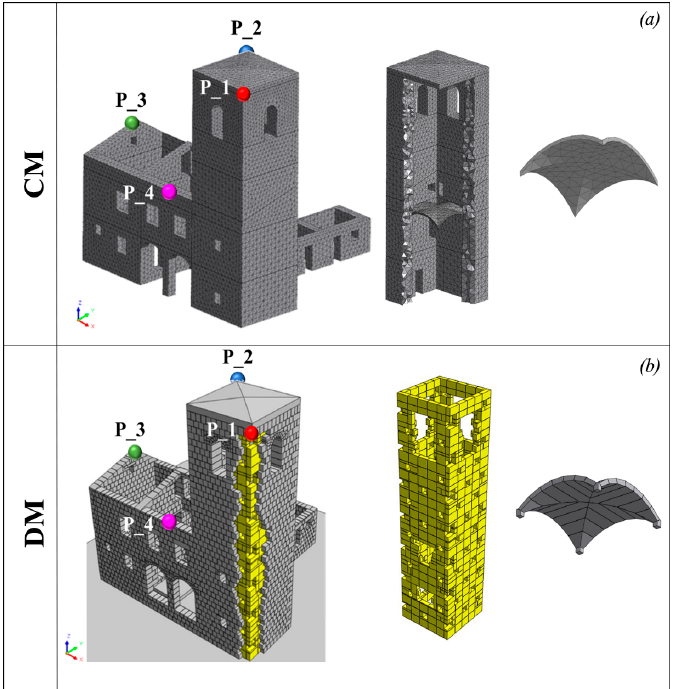
Figure 6. Comparison between CM ( a ) and DM ( b ) with zooms on the civic tower and a cross vault. In the DM, the inner core stones are reported in yellow (colors in the online version). On the 3D views of the structure, the control points considered to plot the results are